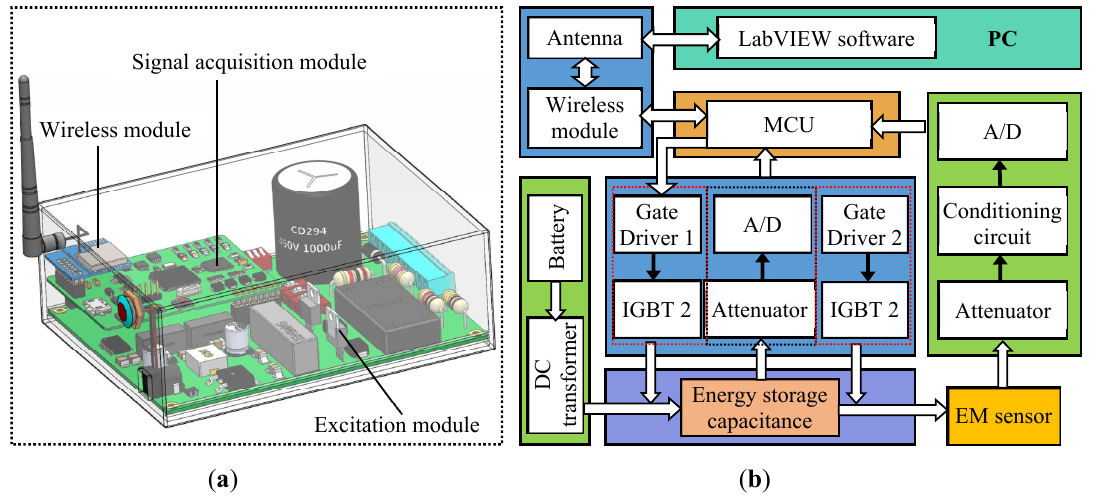
Figure 2. ( a ) Three-dimensional (3D) assembly drawing and ( b ) frame diagram of the developed EM device.